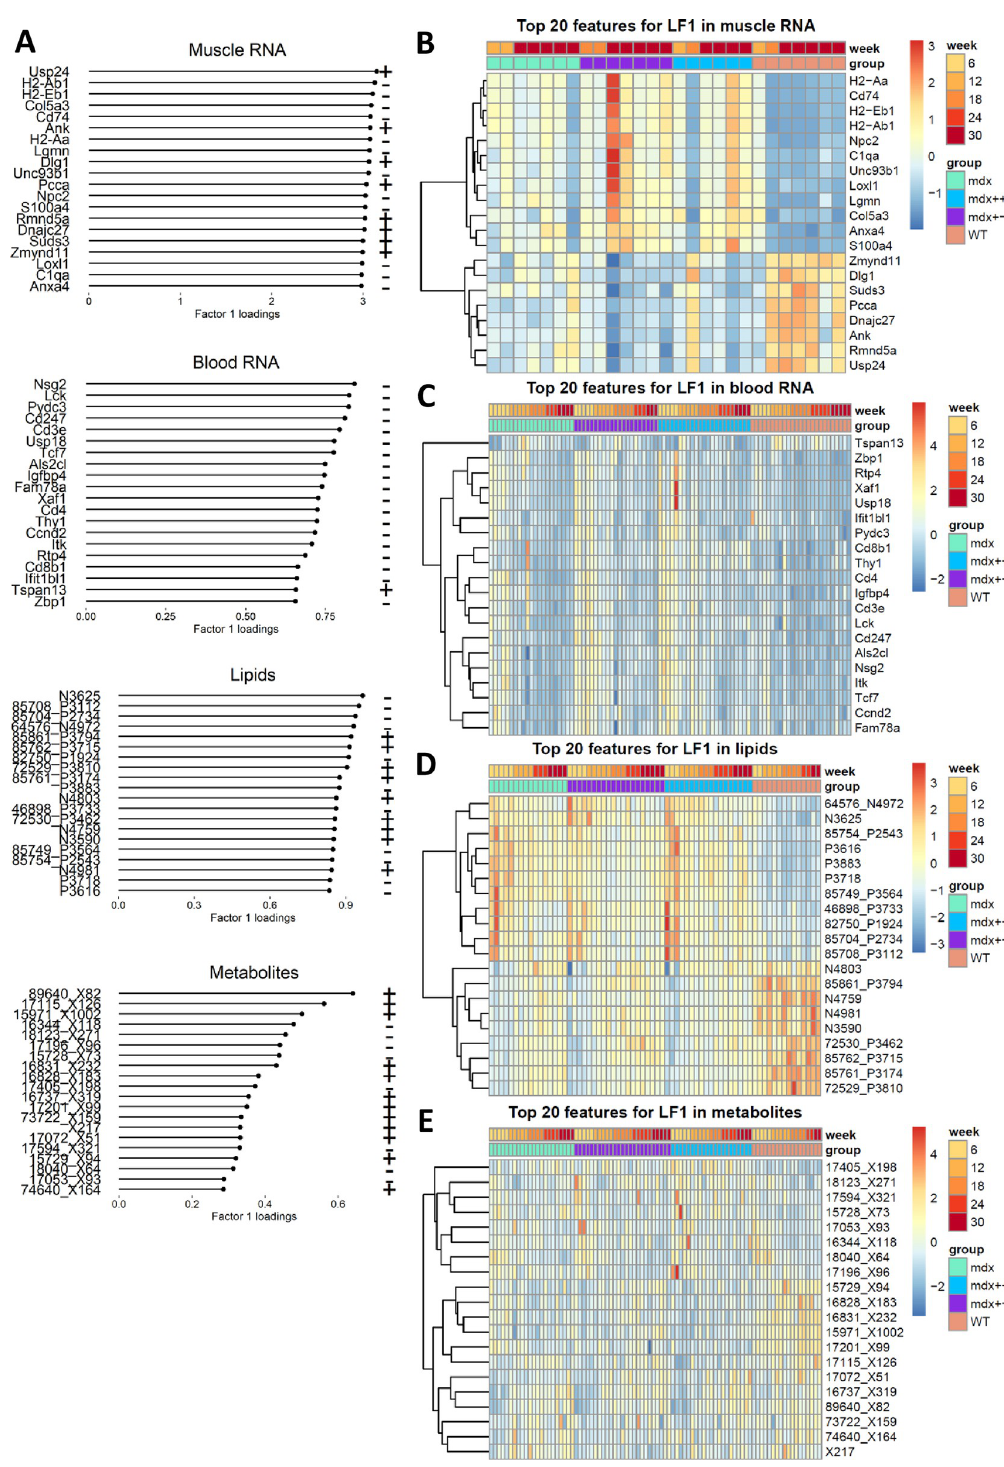
Fig 4. MOFA factor 1: Top 10 molecules by factor weight in each omic view. A) Factor 1 weights for the top 10 genes, lipids and metabolites by factor weight in muscle RNA, blood RNA, lipids and metabolites. B-E) Heatmaps showing the distribution of the top 10 molecules by factor weight in muscle RNA (panel B), blood RNA (panel C), lipids (panel D) and metabolites (panel E) across samples.